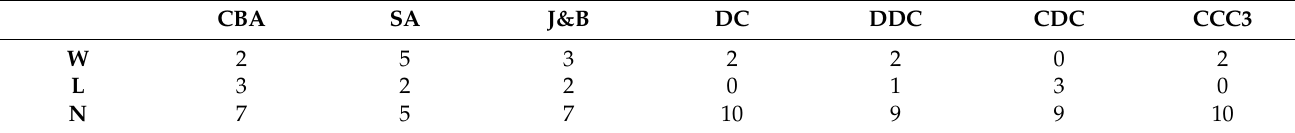
Table 4. Statistically significant wins/losses counts of CCC2 method on accuracy.